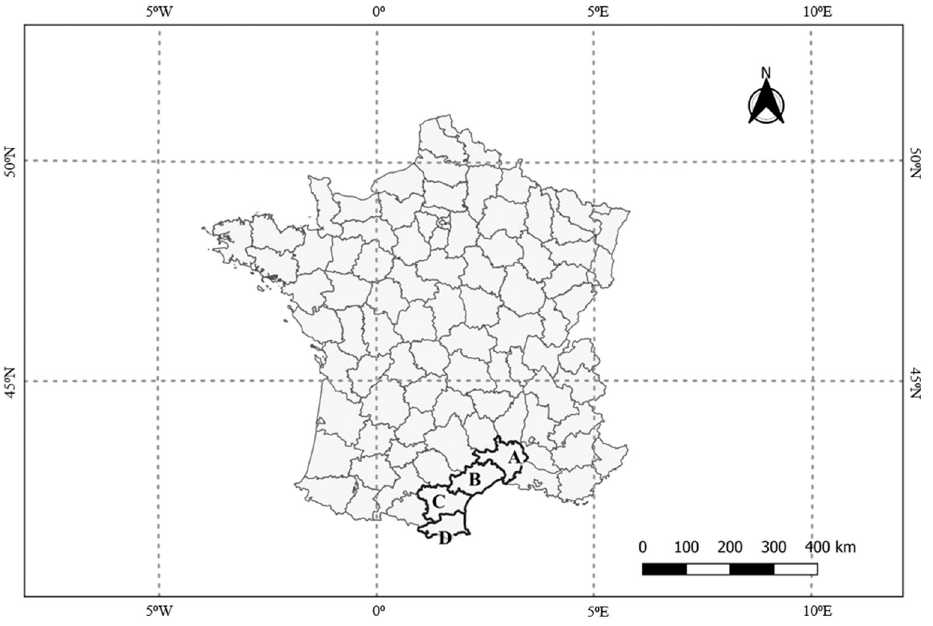
Figure 1. Location of the study area in Southern France for the four administrative sectors: Gard (A), Hérault (B), Aude (C) and Pyrénées-Orientales